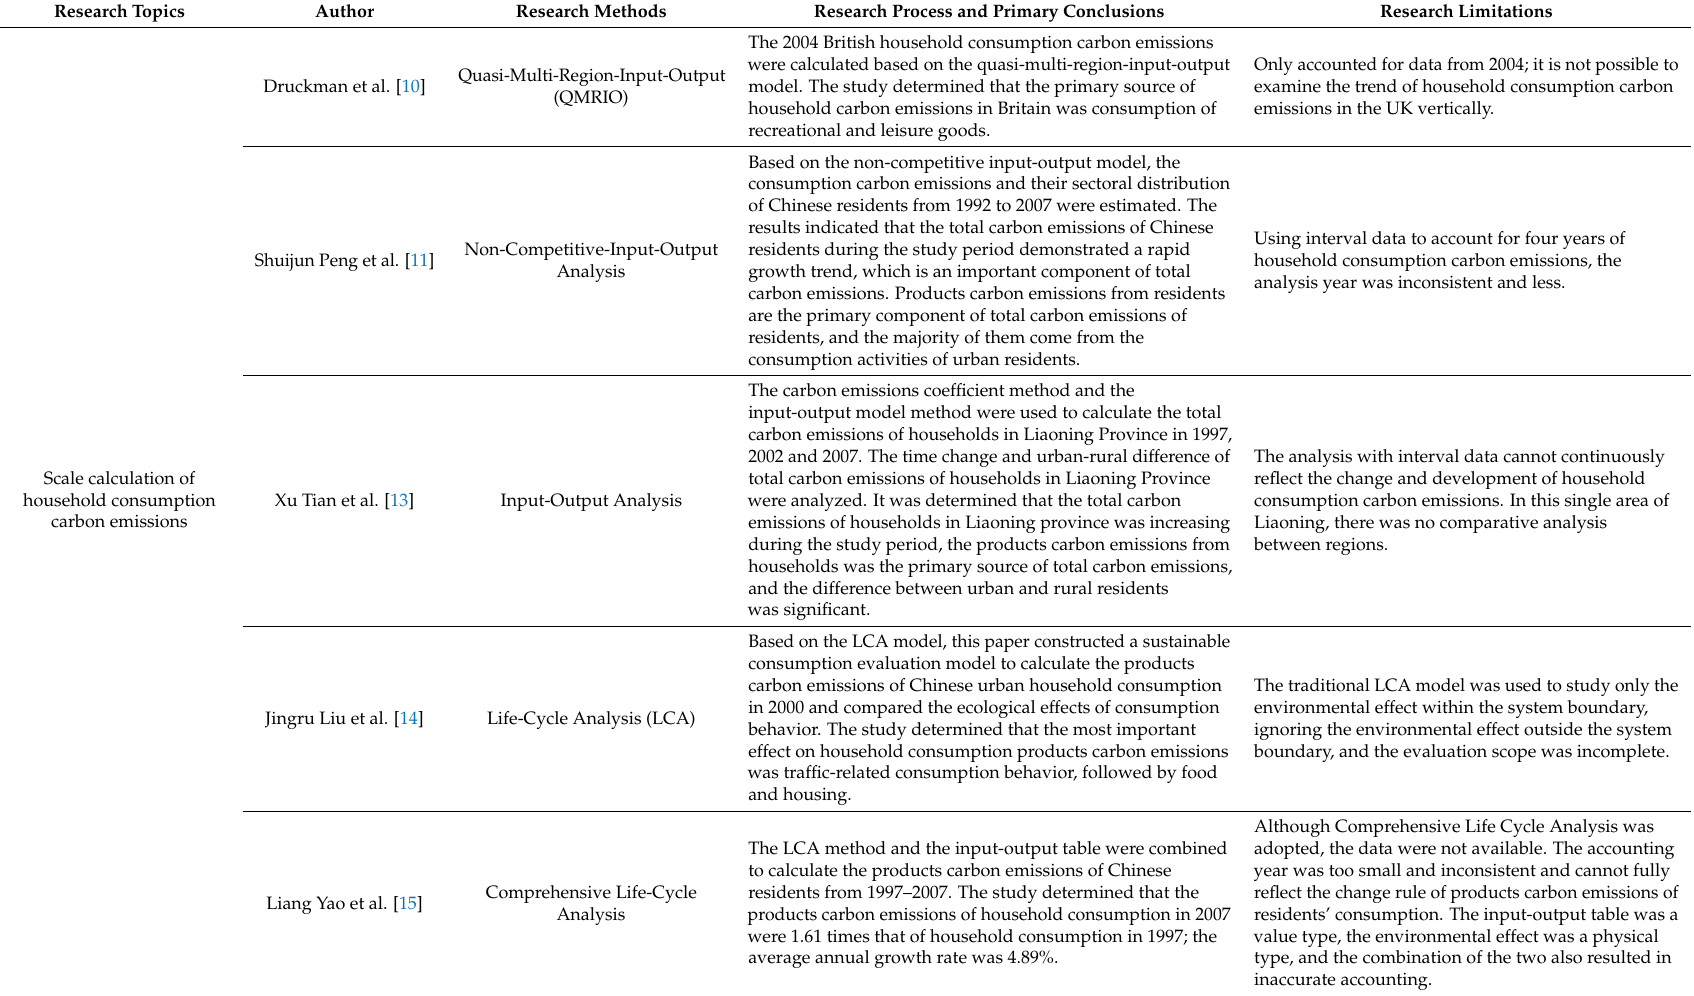
Table 1. Summary of household consumption carbon emission